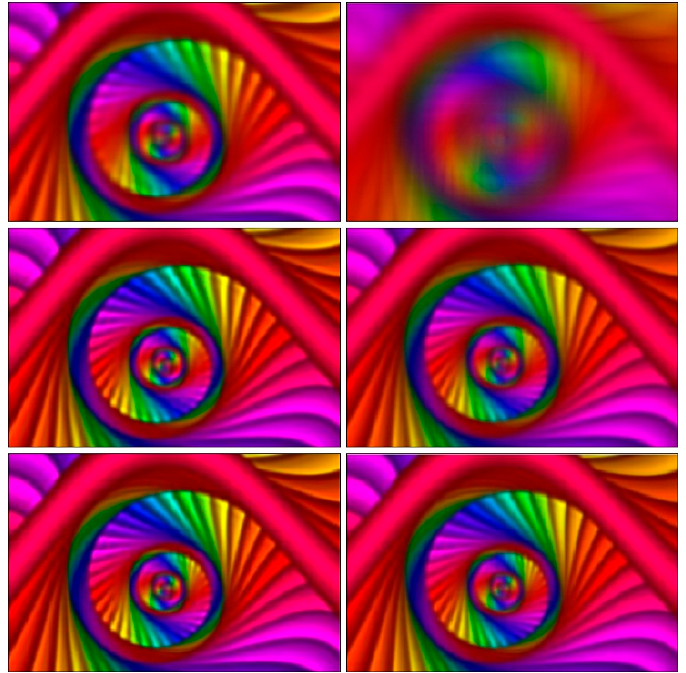
Figure 15. Modeling image deconvolution outside the focal plane ( z = 120 mm) for a lens without apodization (upper row) and with phase apodization n = 3 (middle row) and n = 4 (lower row) using PSF at z = 120 mm plane (left column) and PSF in the focal plane z = f = 100 mm (right column).